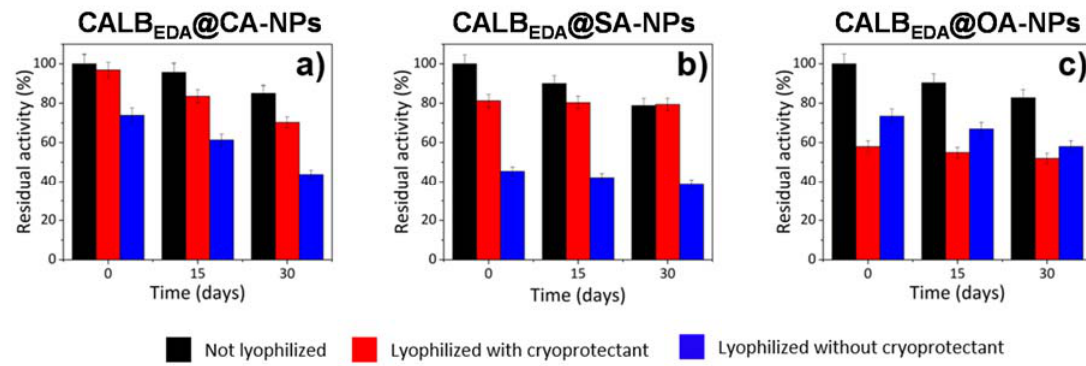
Figure 7. Retained activity of different CALB EDA nanoderivatives stored in aqueous suspension and after lyophilization. Lyophilized samples (stored at 4 °C) were re-suspended in phosphate buffer 10 mM prior to measure the catalytic activity retained by CALB EDA over the storage time. ( a ) Retained activity of CALB EDA @CA-NPs, ( b ) retained activity of CALB EDA @SA-NPs and ( c ) retained activity of